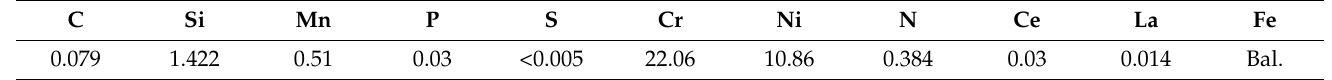
Table 1. Chemical composition of 253 MA ASS